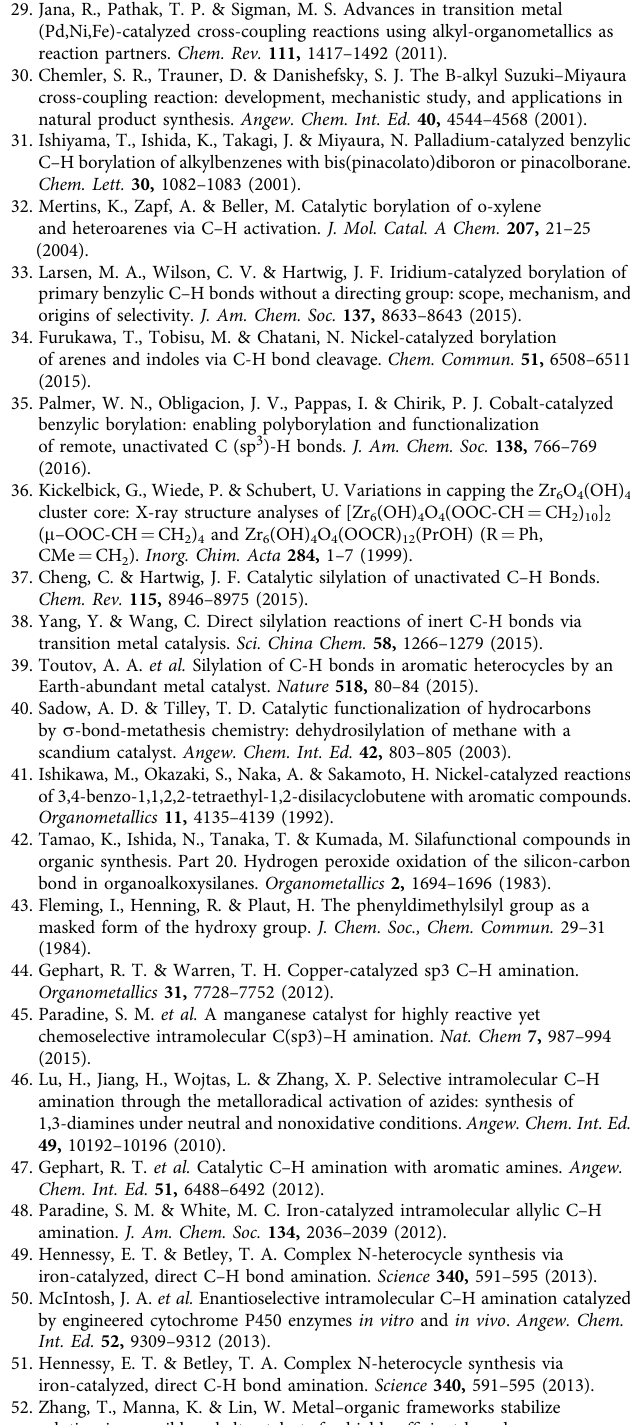
1440158. The crystallographic files can be obtained free of charge from the Cam- bridge Crystallographic Data Centre via http://www.ccdc.cam.ac.uk/data_request/cif. All other data are available from the authors upon reasonable